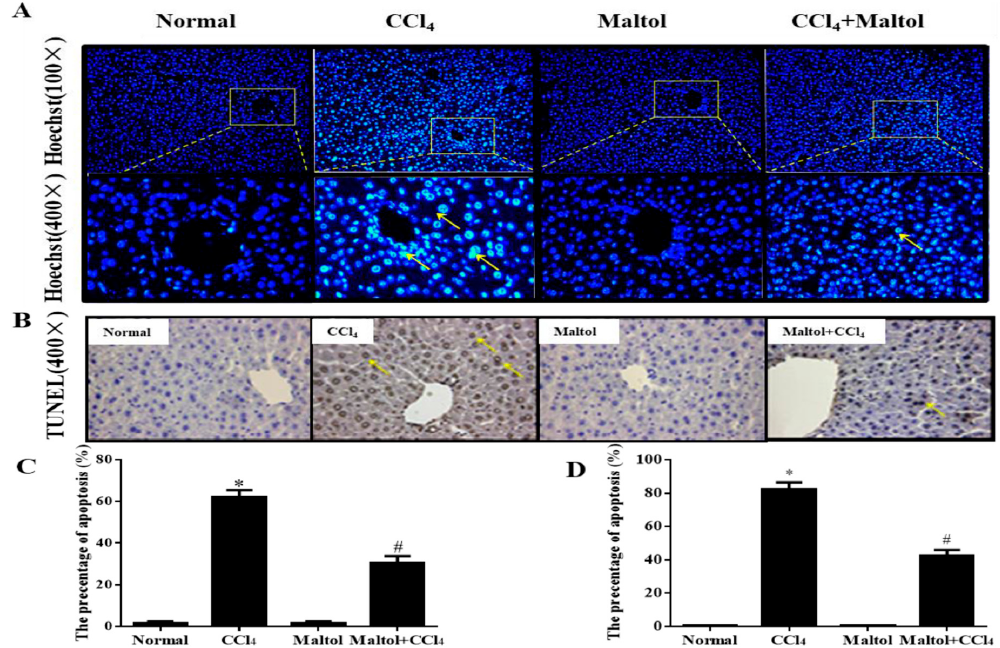
Figure 3. Effects of maltol on CCl 4 -induced inhibited cell apoptosis: Hoechst 33258 ( A ). Original magnification: 100 × and 400 × . The yellow arrows show apoptosis cells. The mean optical density of Hoechst 33258 staining is shown in ( C ). The effects of maltol on hepatic apoptosis examined with TUNEL is shown in ( B ). Original magnification: 400 × . The percentage of positive cells of liver cells stained with TUNEL is shown in ( D ). Values are expressed as the mean ± S.D., n = 8. * p < 0.05 vs. normal group; # p < 0.05 vs. CCl 4 group.